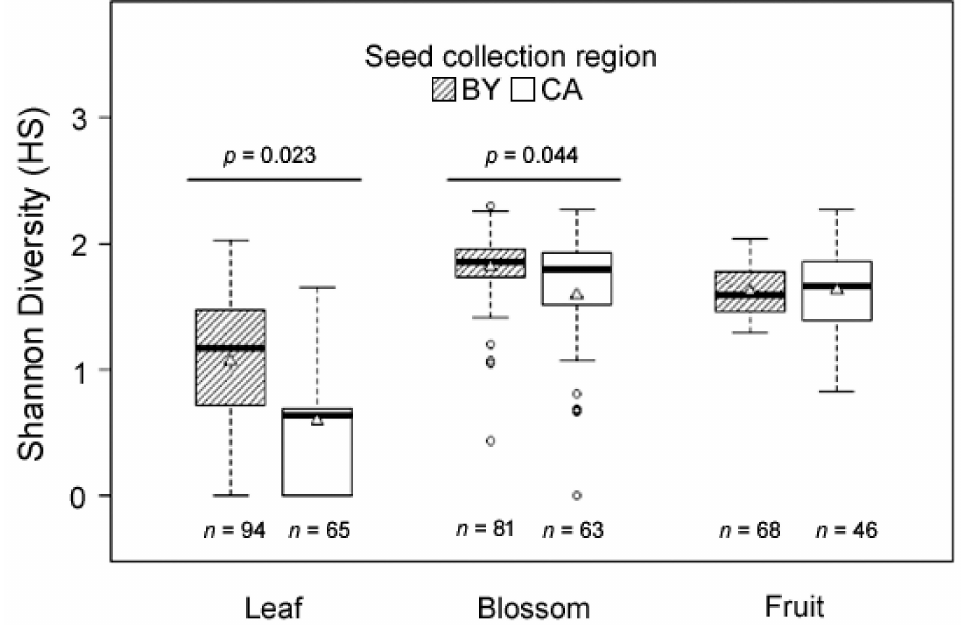
Figure 4. Shannon diversity index of relative terpenoid abundance detected in Erodium cicutarium plant parts. Seeds were collected in the field from Bavarian sites (BY, native range) and Californian sites (CA, invasive range). Plant parts of the second greenhouse generation were analyzed. The box plots represent medians (horizontal lines within boxes), upper and lower quartiles (box dimensions), 75% and 25% quartiles (whiskers) and outliers (circles). The mean values are shown by white triangles in